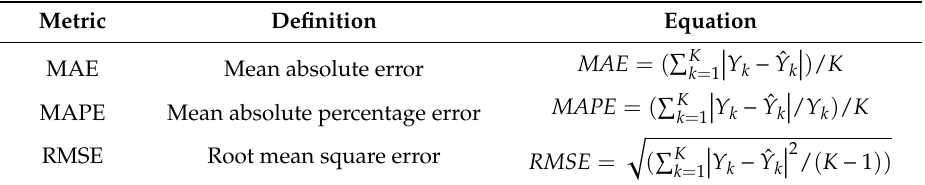
Table 3. The indicators for the model performance evaluation.